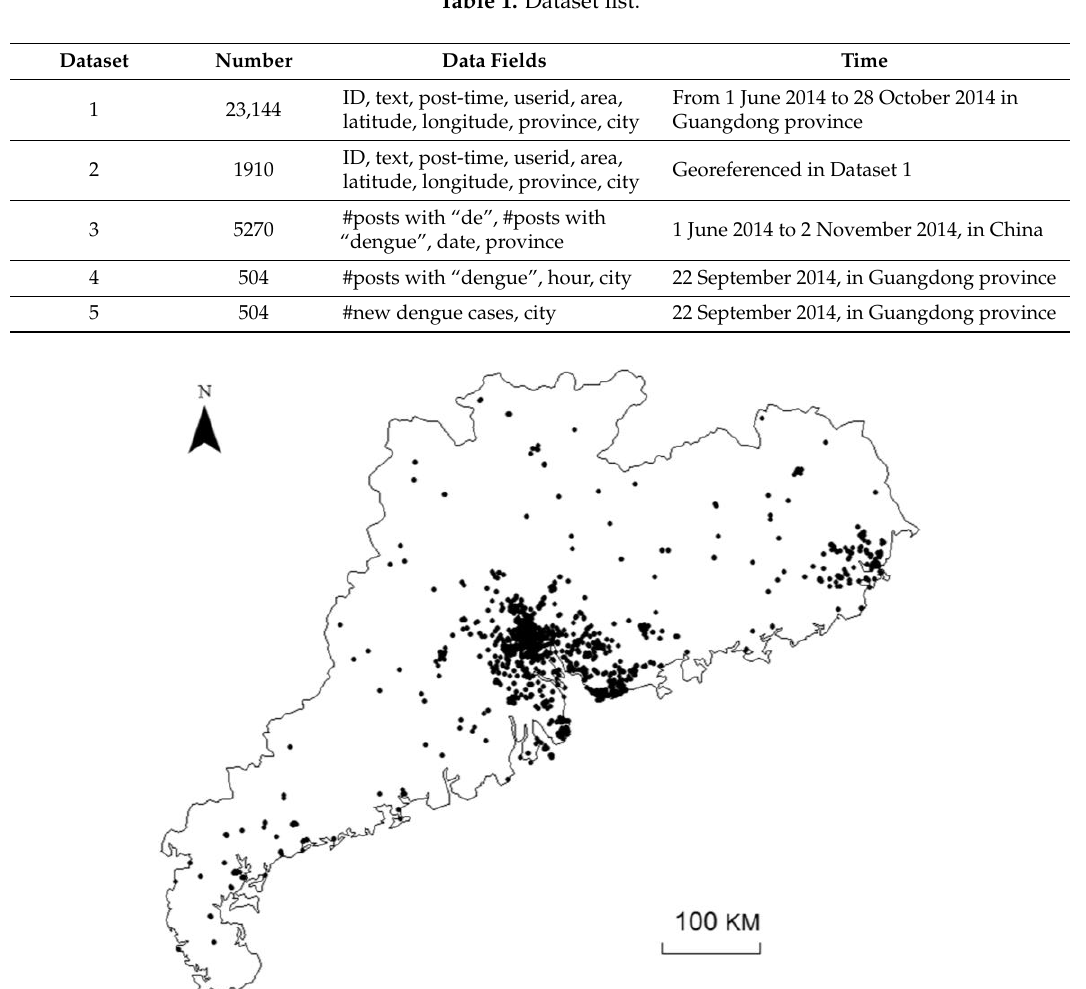
Figure 2. Location of the posts with ‘Guangdong’ as the value for the area attribute.